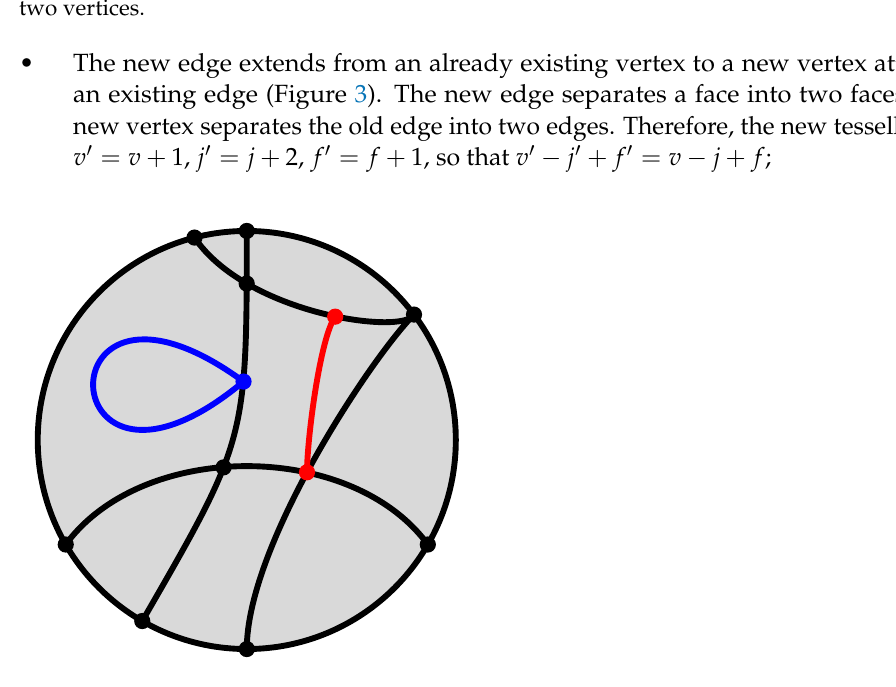
Figure 3. The blue edge starts and ends at the same new vertex, while the red one starts from an old vertex and ends in a new one.